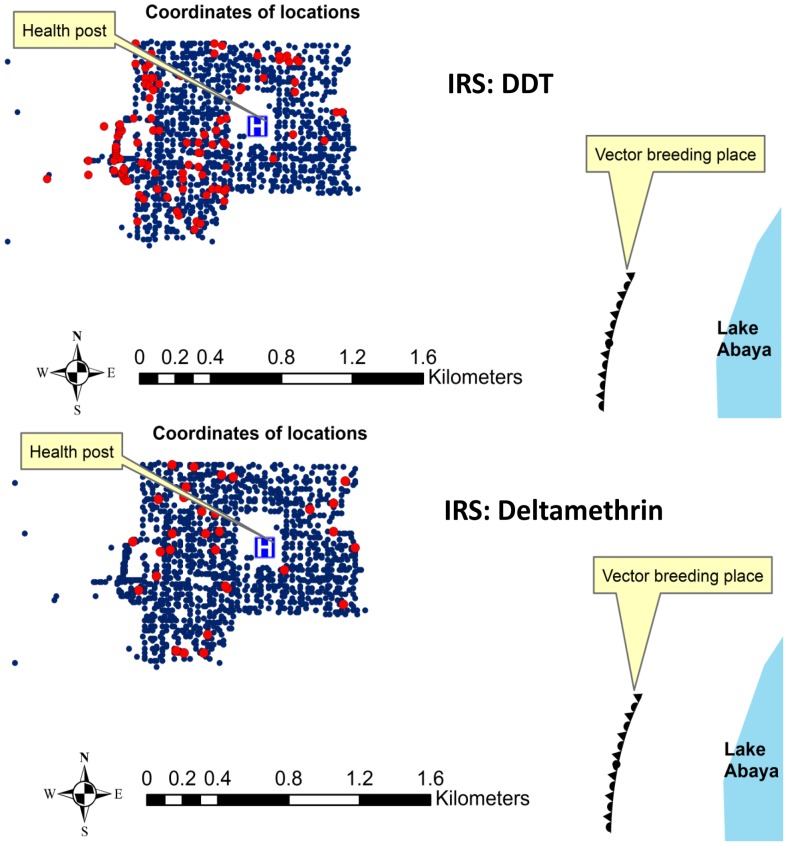
Spatial coverage of indoor residual spraying (IRS) with DDT and Deltamethrin: Red dots refer to houses that were not sprayed and smaller blue dots refer to sprayed houses.